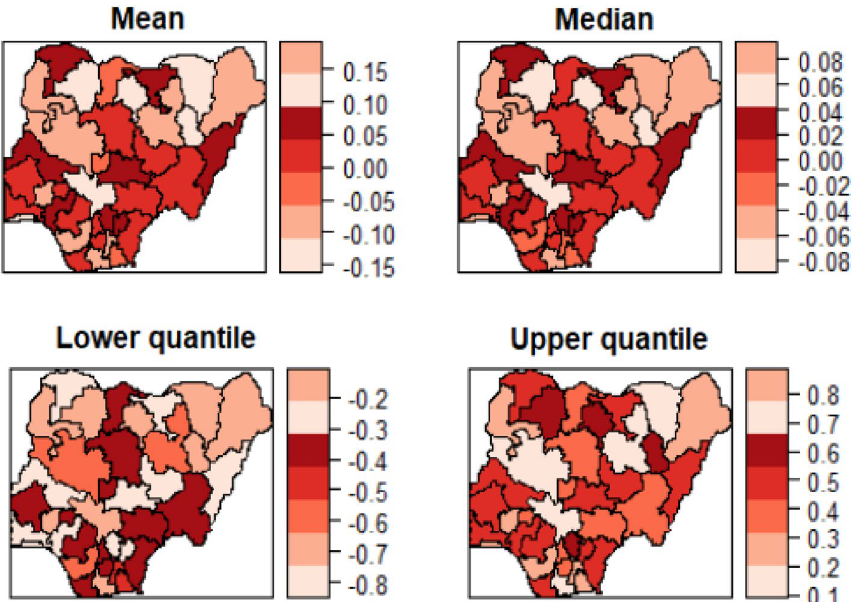
Figure 6. Nigeria state-level e stimated posterior mean of the unstructured spatial effect maps: (a) Mean, (b) Median, (c) 25% quantile and 97.5% quantile for